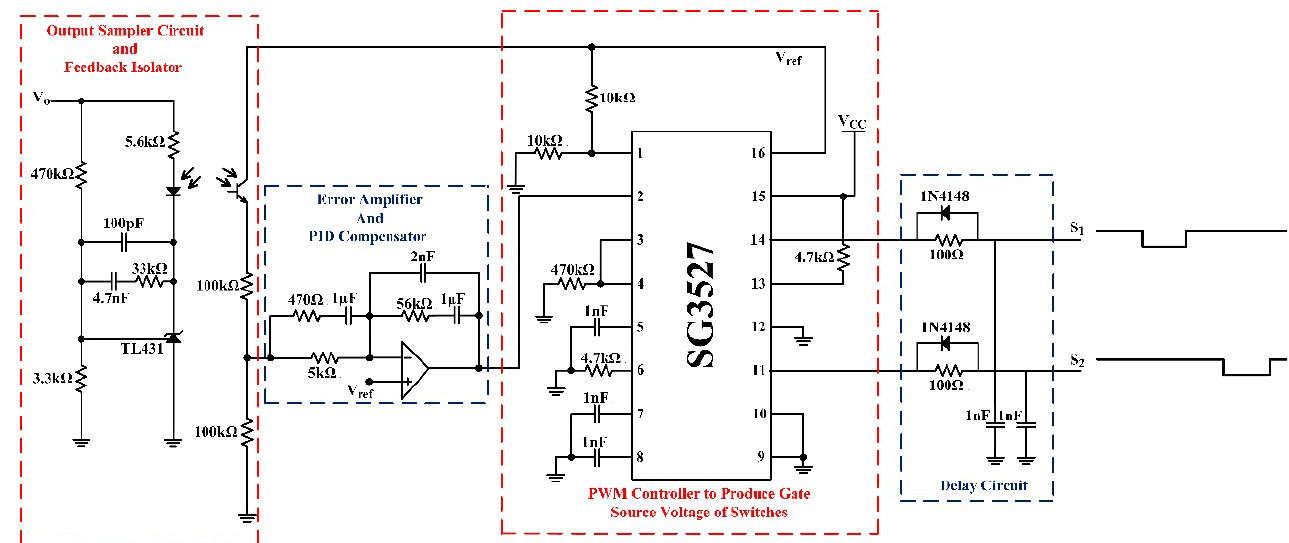
Figure 6. Experimental control circuit.